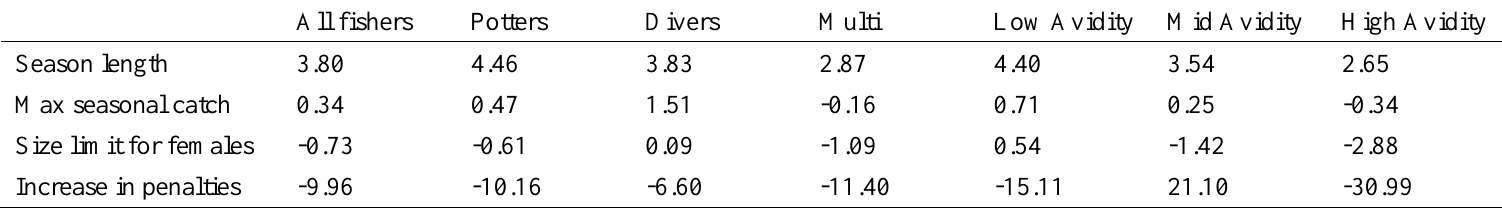
Table A.4. Trade-offs fishers are willing to make between a reduction in bag limit by one lobster and a change in season length, maximum seasonal catch, minimum size limit for females, and penalties for non-compliant